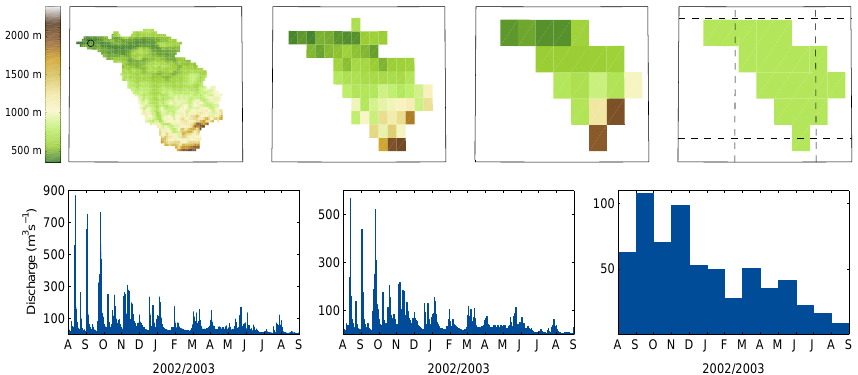
Figure 1. Overview of the spatial and temporal resolutions employed in this study. Top panels from left to right: DEM (digital elevation model) grid cells for 1km × 1km, 5km × 5km, 10km × 10km resolution and the lumped model. The circle in the left panel shows the location of the Thur outlet where the discharge is measured. The dotted lines in the right panel indicate a 0.5 ◦ grid. Bottom panels: the three temporal resolutions; observed discharge at an hourly, daily and monthly time step.